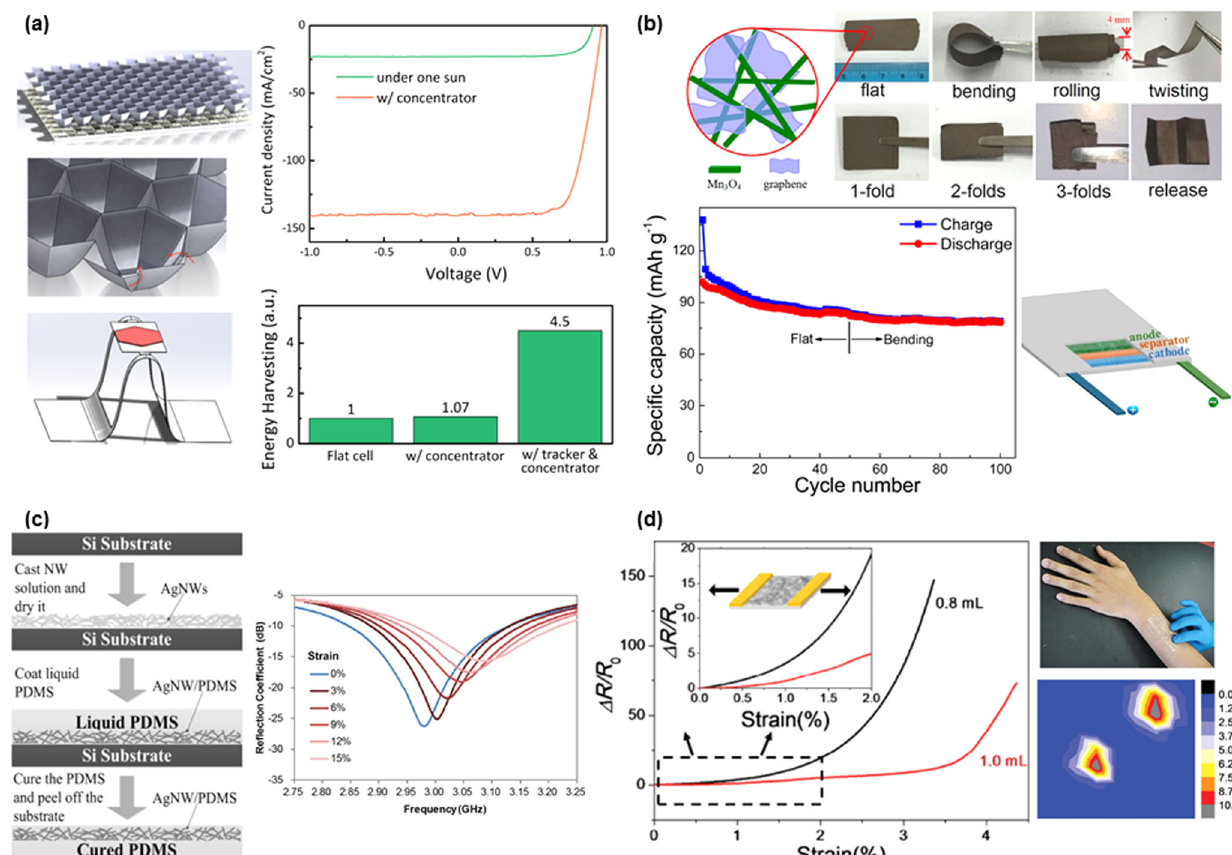
Fig. 7 Discrete components. a Solar cells with origami concentrators (lower left) and trackers (lower right) show signi fi cant improvements in diurnal energy output and light harvesting ef fi ciency. Reprinted with permission from ref. 73. b (Top) digital photos of the rGO/Mn 3 O 4 membrane in various deformation states (bending, rolling, twisting, and 1, 2, 3-fold; rGO, reduced graphene oxide). (Bottom) cycling performance of a fl exible rGO/Mn 3 O 4 || LiMn 2 O 4 full battery, with 3D schematic con fi guration shown on the right. Reprinted with permission from ref. 76. c Screen-printed silver nanowires embedded in the surface layer of a soft PDMS substrate form highly conductive and stretchable material for mechanically tunable patch antennas with an increased resonance frequency for an increasing stretching. Reprinted with permission from ref. 80. d Sliding between adjacent graphene fl akes changes the graphene connection channel and its tunneling effect. The high resistance change from such sliding is exploited for wearable strain sensors to map pressures applied from two fi ngertips on the forearm. Reprinted with permission from ref.